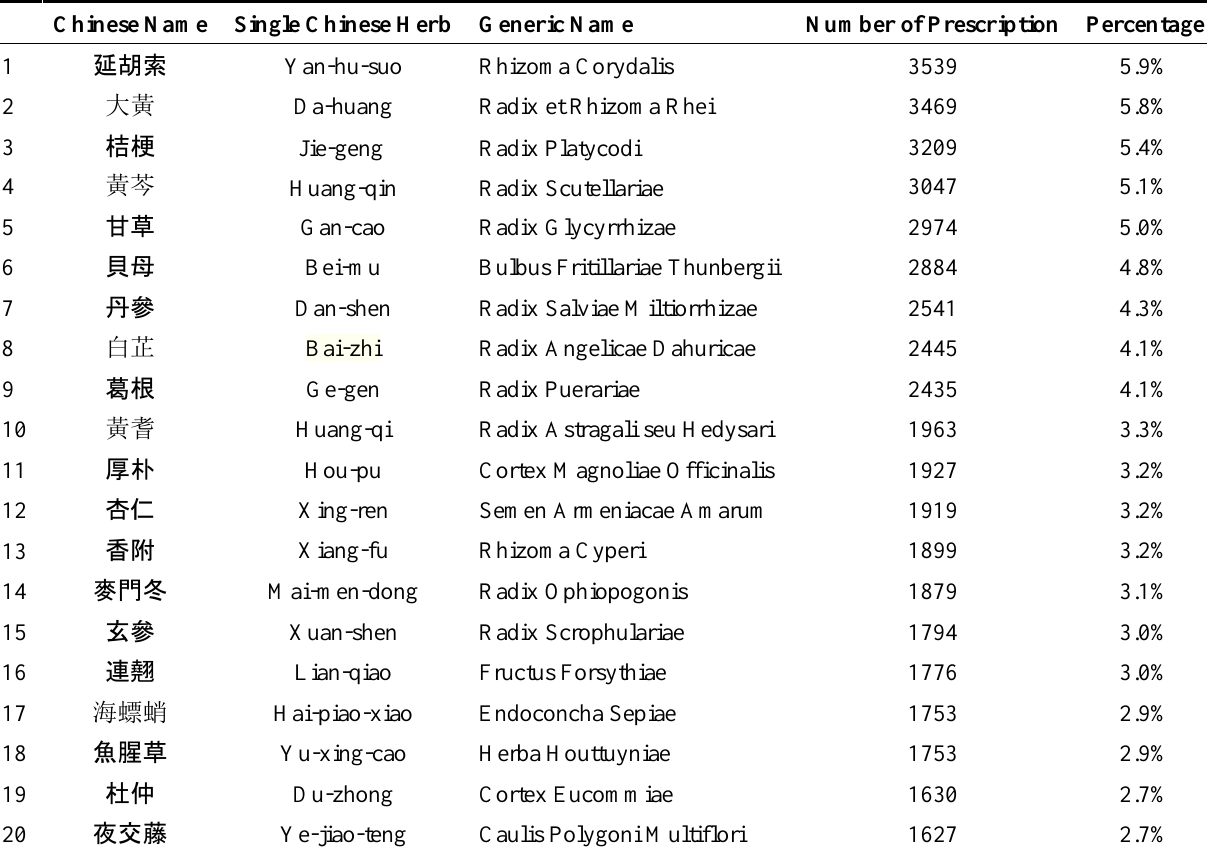
Table 2. Top 20 single Chinese herbs (CHs) prescribed in Taiwan in 2010 (total prescription number, n =